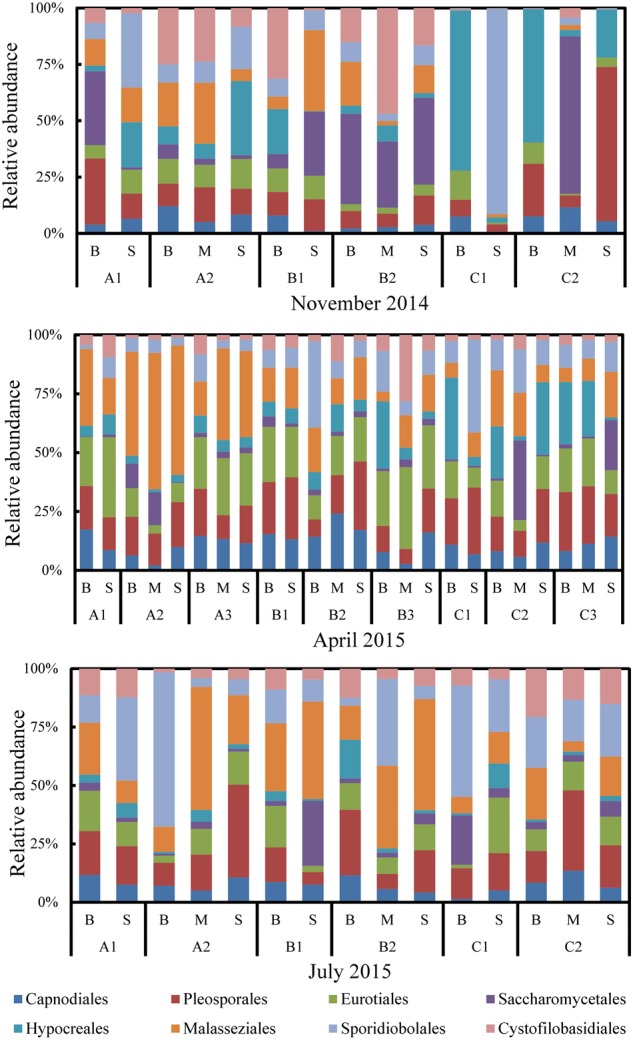
Composition of dominant planktonic fungal orders across all samples collected from Qinhuangdao coastal area.